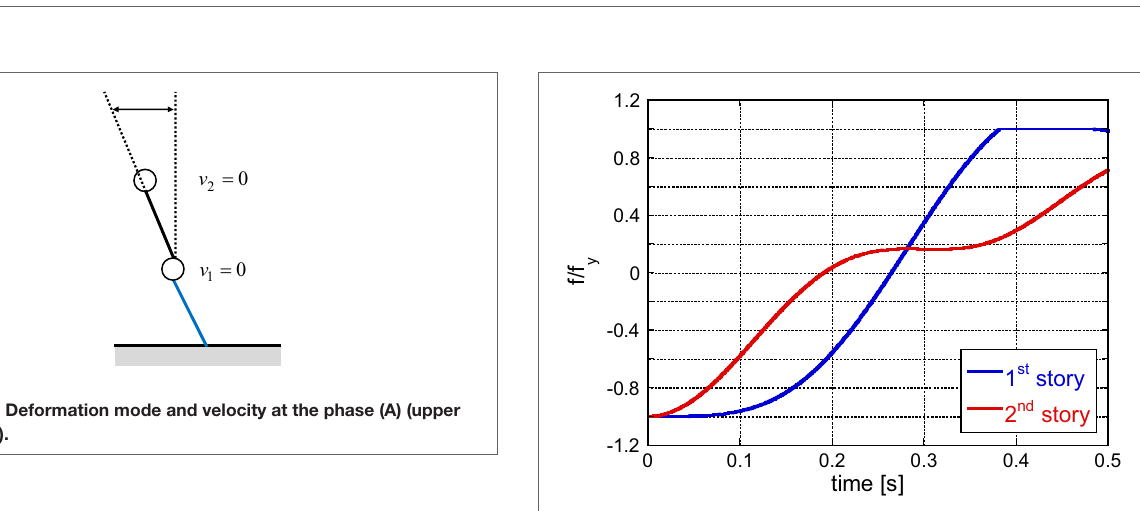
FigUre 14 | Time histories of the restoring forces in the first and second stories for the same 2DOF model subjected to the double impulse with V / V y = 1.11, 3.33, 5.55 . (a) V / V y = 1.11 ( t 0 c = 0.535 [s]). (B) V / V y = 3.33 ( t 0 c = 0.946 [s]). (c) V / V y = 5.55 ( t 0 c = 1.384 [s]).